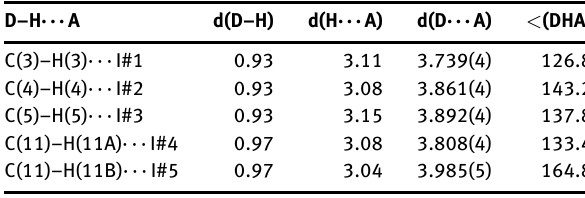
Table 3: ‘Weak’ hydrogen bonds, in Ångstroms and